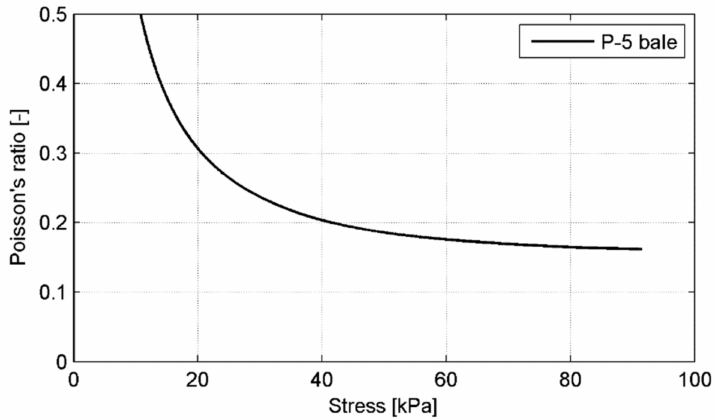
Figure 16. Poisson’s ratio variability for P-5 bale under increasing load.